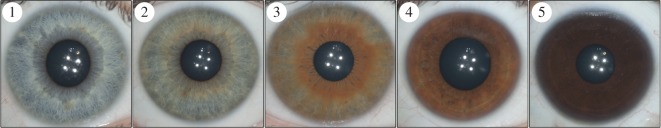
Self-described iris colour, as defined by the Fitzpatrick Phototype Scale. The Fitzpatrick scale characterizes iris colour across five categories: 1, light blue green or grey; 2, blue, green or grey; 3, hazel or light brown; 4, dark brown; and 5, brownish black. The photographs above represent a self-described example from each of the five categories.